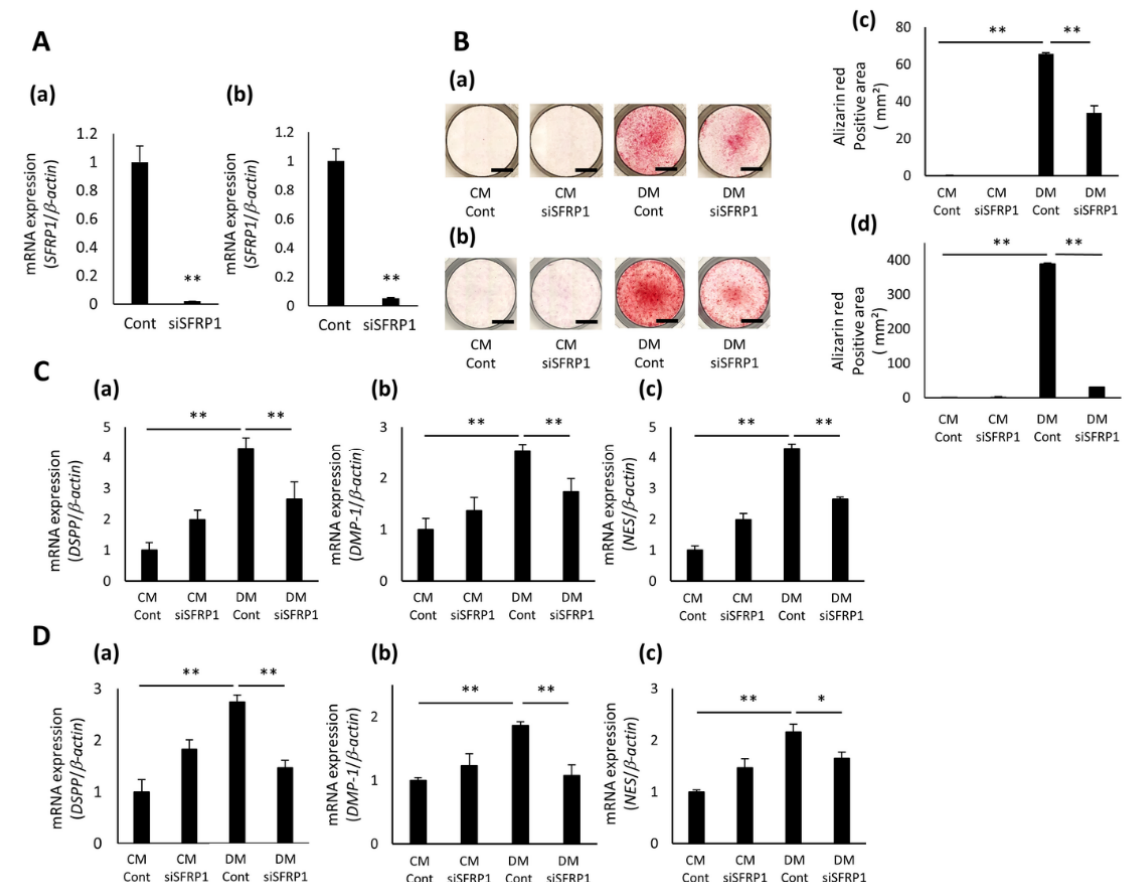
Figure 3. Effects of SFRP1 down-regulation on odontoblastic differentiation in hDPCs. ( A ) SFRP1 gene expression in hDPC-5N ( a ) and -5I ( b ) transduced with control siRNA (Cont) or SFRP1 siRNA (siSFRP1). ( B ) Odontoblastic differentiation of siRNA-transduced hDPC-5N and -5I. Images of Alizarin Red S staining of siRNA-transduced hDPC-5N ( a ) and -5I ( c ) cultured in CM or DM for 5 days. Experiments were performed in quadruplets. Representative data are shown. The Alizarin Red S-positive area of siRNA-transduced hDPC-5N ( b ) and -5I ( d ) cultured in CM or DM for 5 days. Gene expression of DSPP ( a ), DMP1 ( b ), and NES ( c ) in siSFRP1-transduced hDPC-5N ( C ) and -5I ( D ) cultured in CM or DM for 2 days. Data are shown as the mean ± standard deviation ( n = 3). * p < 0.05, ** p < 0.01. Scale bars = 5 mm.